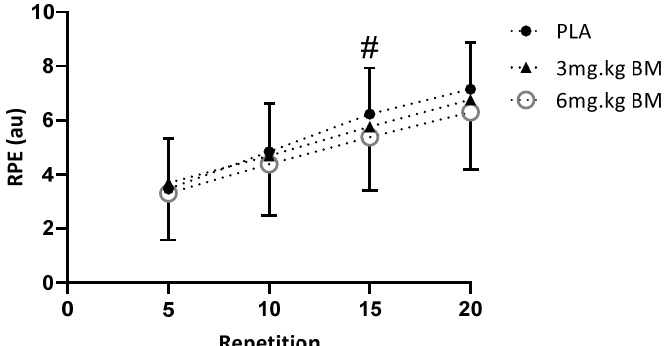
Figure 3. Rating of Perceived Exertion between conditions and repetitions during the endurance performance test at 60% 1RM. # Condition effect identified ( p < 0.05), but no post hoc difference was statistically significant.